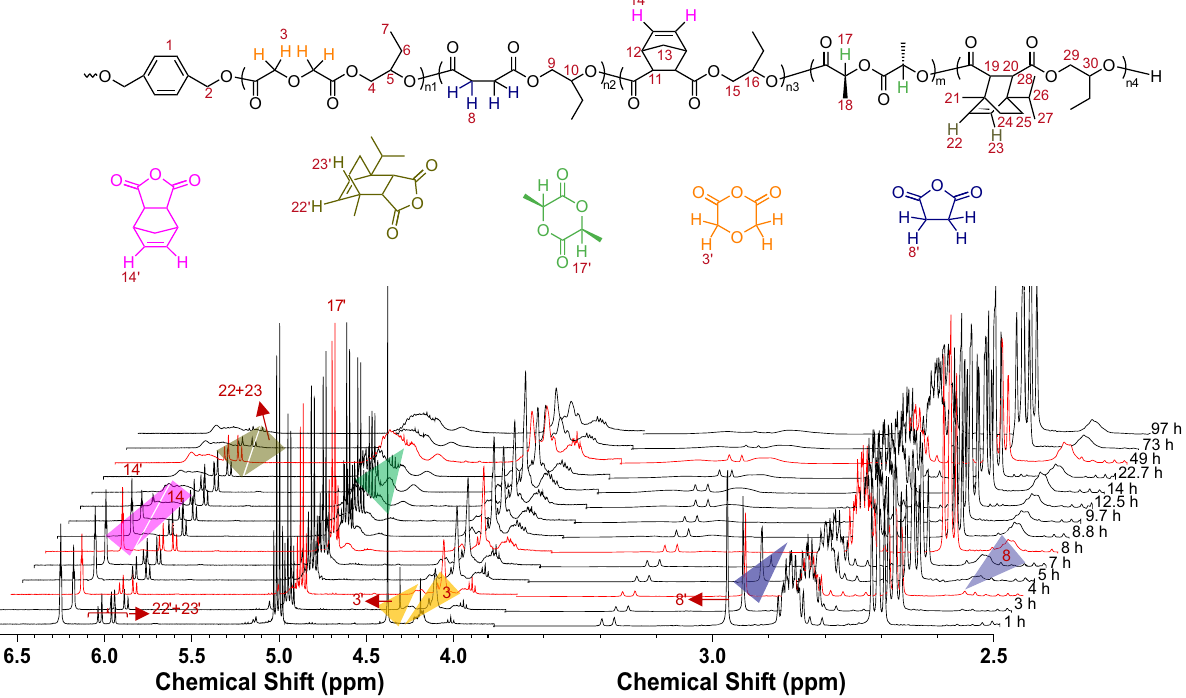
Fig. 5 The 1 H NMR (CDCl 3 ) spectra analysis of the self-switchable polymerization from the mixture of DGA/SA/NA/ L -LA/DPMA/BO. The 1 H NMR (CDCl 3 ) spectra of crude aliquots withdrawn from the reaction system for monitoring the conversion of DGA, SA, NA, DPMA, L -LA, and the formation of resultant polymers (entry 7 in Table